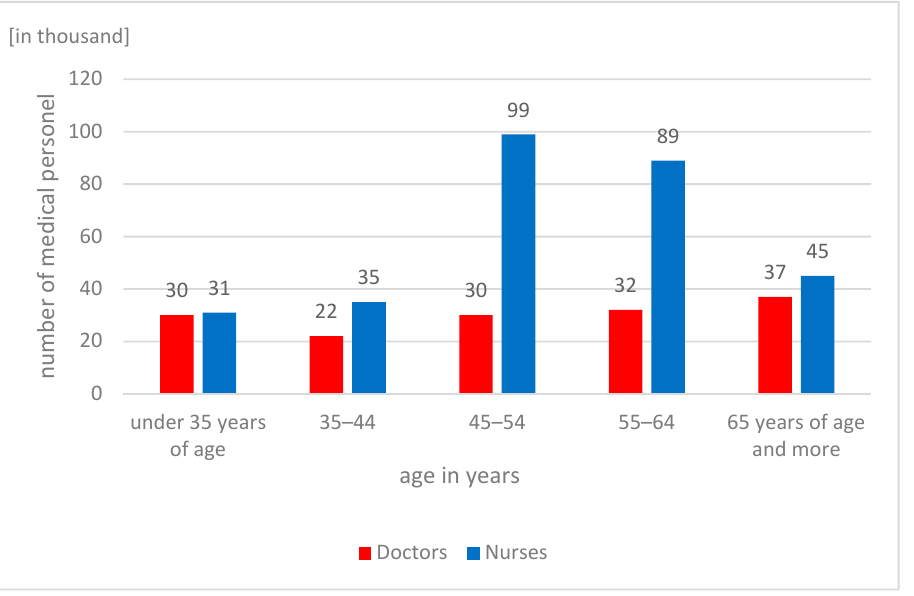
Figure 1. Medical and nursing staff divided into age groups. Status for 2019. Source: Own study based on the data of the Central Statistical Office.